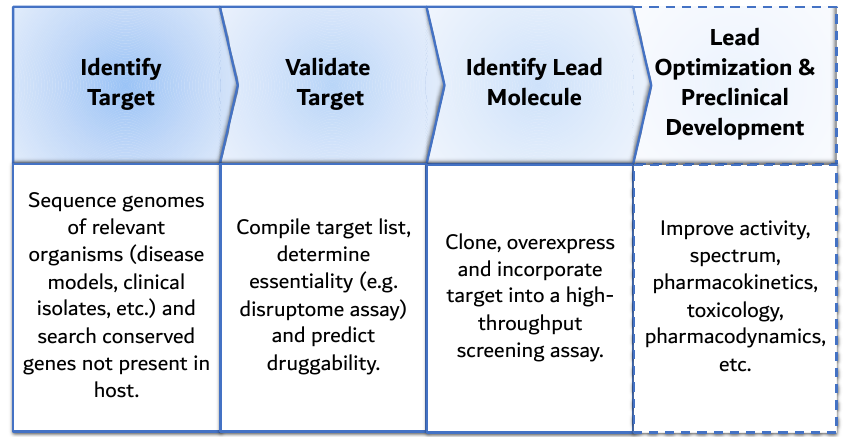
Figure 3. Schematic representation of the target-based antibiotic discovery platform: potential targets are identified from the genome sequence of pathogens and the host, the products of genes exclusive and essential for bacteria are incorporated into high-throughput screening assays, which identify drug candidates suitable for lead optimization and preclinical development. The latter falls outside the scope of antibiotic discovery, thus it is not discussed.